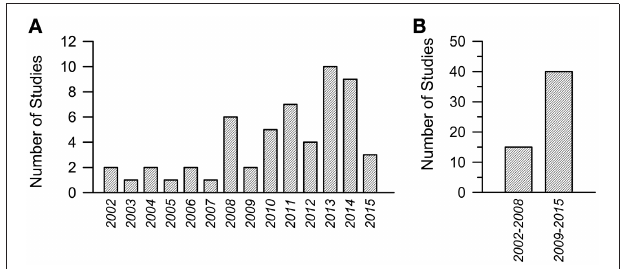
FIGURE 1 | Number of studies focused on pharmacotherapies in Down syndrome mouse models in the period 2002–2015. (A) Number or studies per year. (B) Cumulative number of studies in the period 2002–2008 and